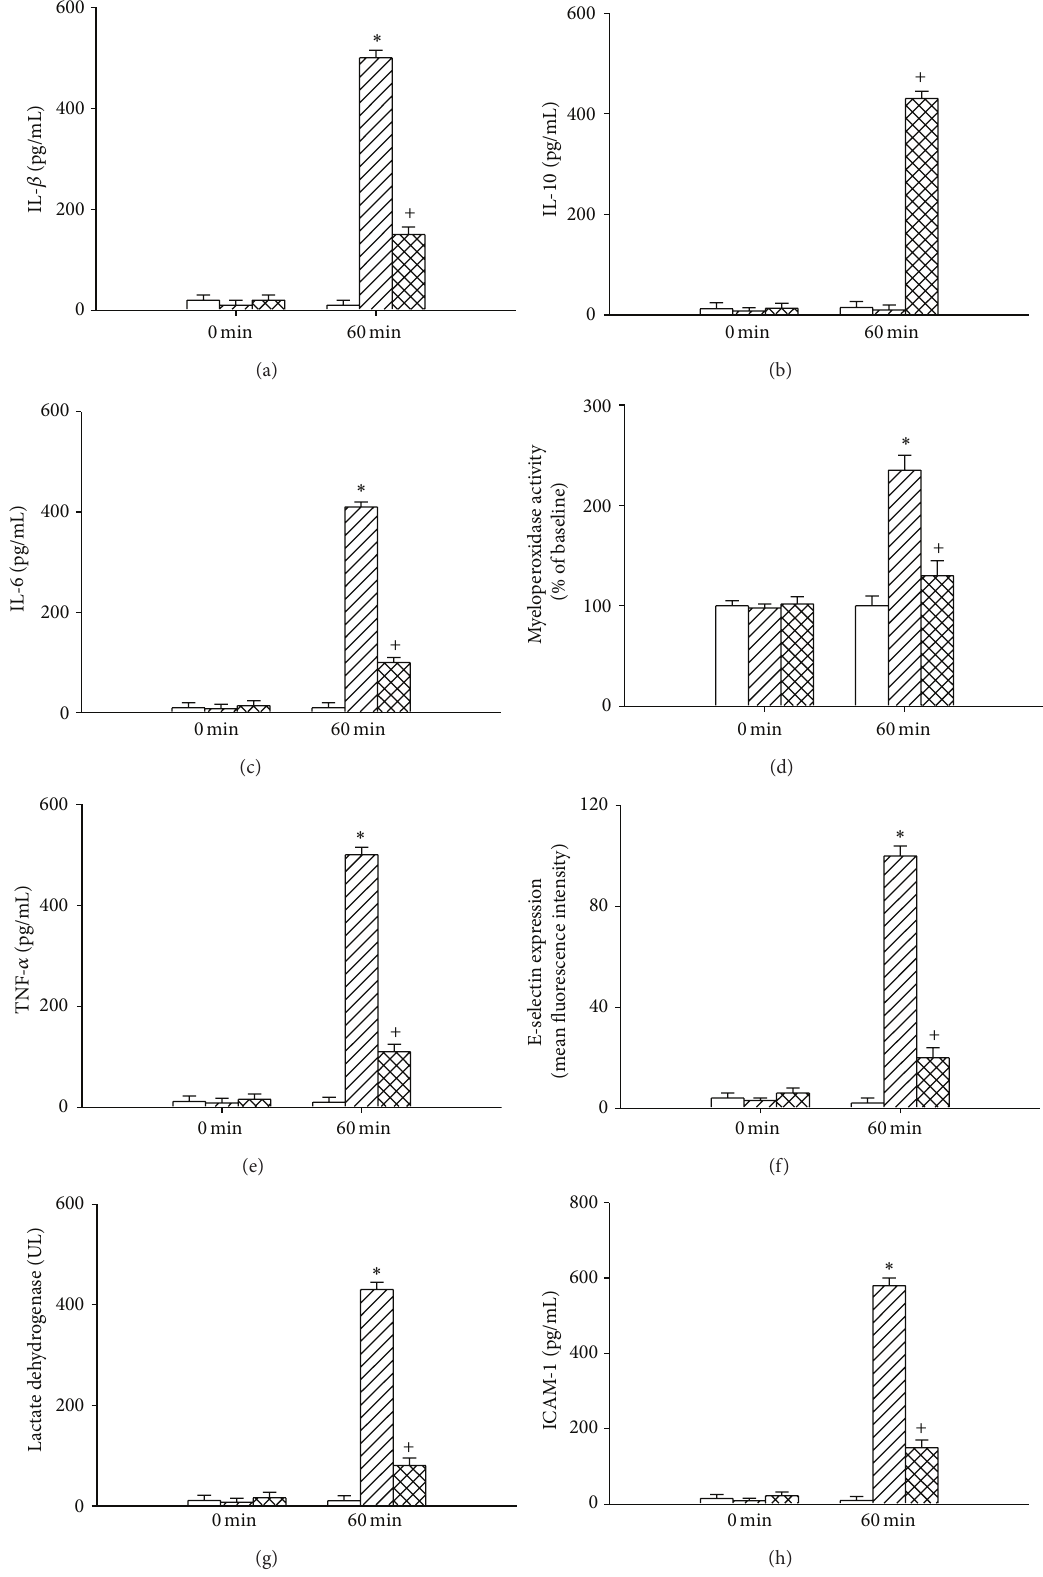
Figure 5: Values of serum interleukin-1 𝛽 (IL- 𝛽 ), IL-6, tumor necrosis factor- 𝛼 (TNF- 𝛼 ), E-selectin, ICAM-1, lactate dehydrogenase, and myeloperoxidase (MPO) for the (NTDR + V) group (white bar), (HSDR + V) group (dashed bar), and (HSDR + H) group (crossed bar). The values obtained at 0 or 60min after the initiation of heat exposure in heatstroke rats or the equivalent times in the (NTDR + V) group. ∗ 𝑃 < 0.01 in comparison with the (white bar) group; + 𝑃 < 0.05 in comparison with the (dashed bar) group. Bars were the mean ± SD of eight rats for each